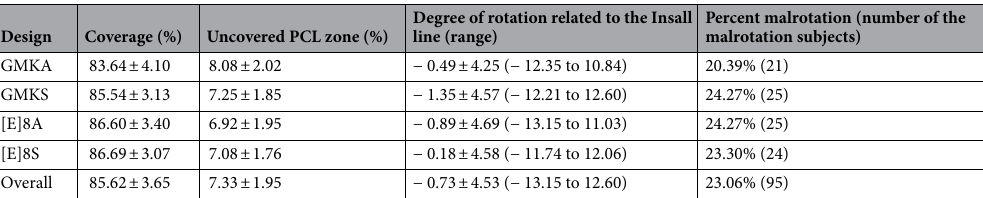
Table 1. The mean ± SD of percent coverage, uncovered PCL zone, degree of rotation and percent malrotation tabulated according to implant design. The positive value represented the external rotation referring to the